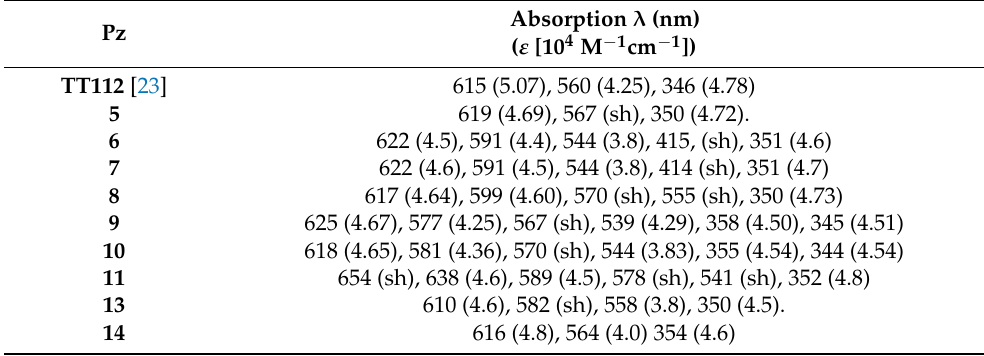
Table 1. Absorption properties of Pzs.